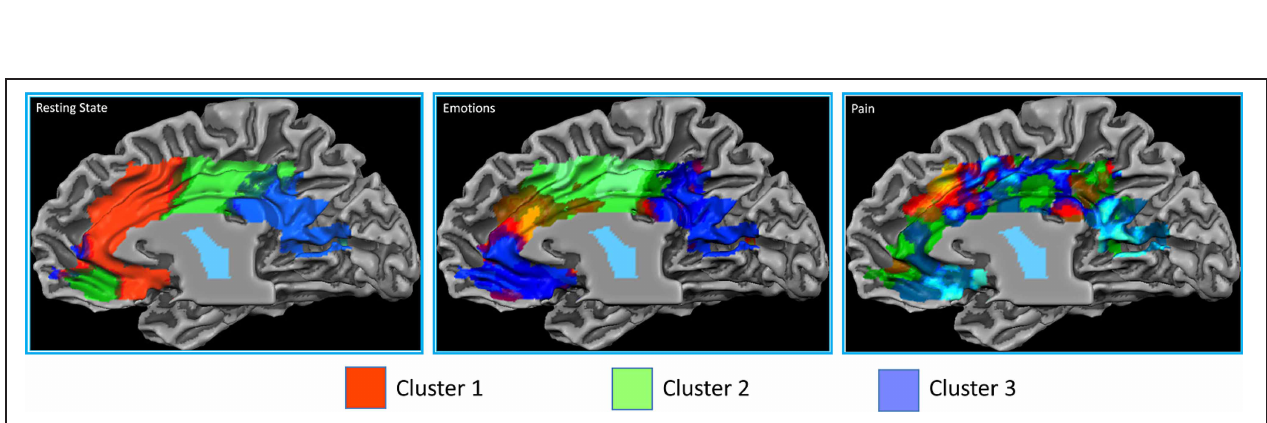
FIGURE 8 | Control experiments. Connectivity-based parcellation of the cingulate cortex in the three datasets. Probabilistic maps for functional connectivity defined clusters. The color scheme represents the probability of overlapping brain areas in each voxel across all the